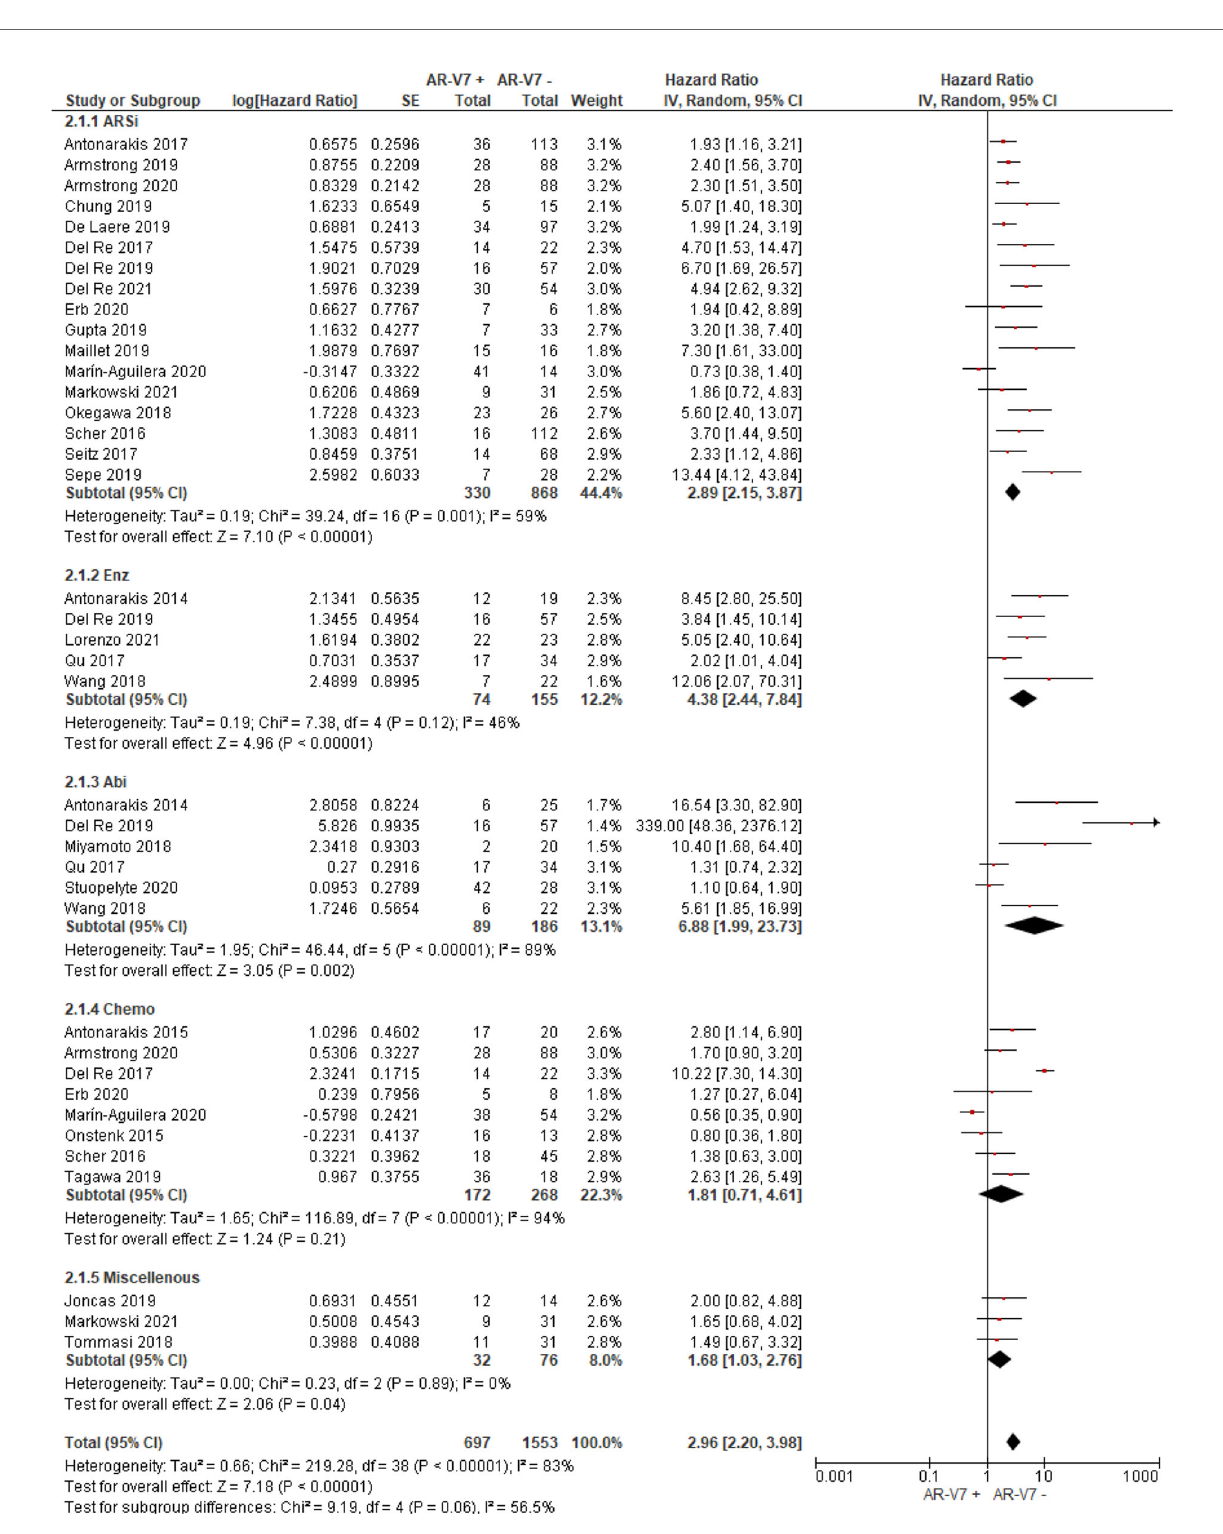
FIGURE 3 | Forest plot of hazard ratios (HRs) for association of liquid biopsy AR-V7 status with PFS in all studies. Pooled HRs were calculated using random effect model. AR-V7: androgen receptor splice variant 7. CI, con fi dence interval and bars indicate 95% CIs. Subgroup analysis (ARSi, enzalutamide or abiraterone; Enz, enzalutamide; Abi, abiraterone; Chemo, taxane based chemotherapy; Miscellaneous, treatments that do not belong to above treatments or not clearly de fi ned) were assessed.